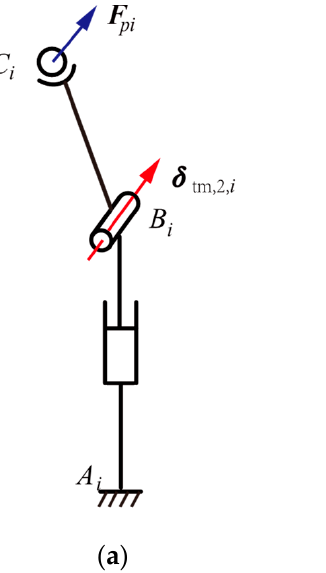
Figure 6. ( a ) The constrained force on the PRS limb; ( b ) The active force on the SPS limb.